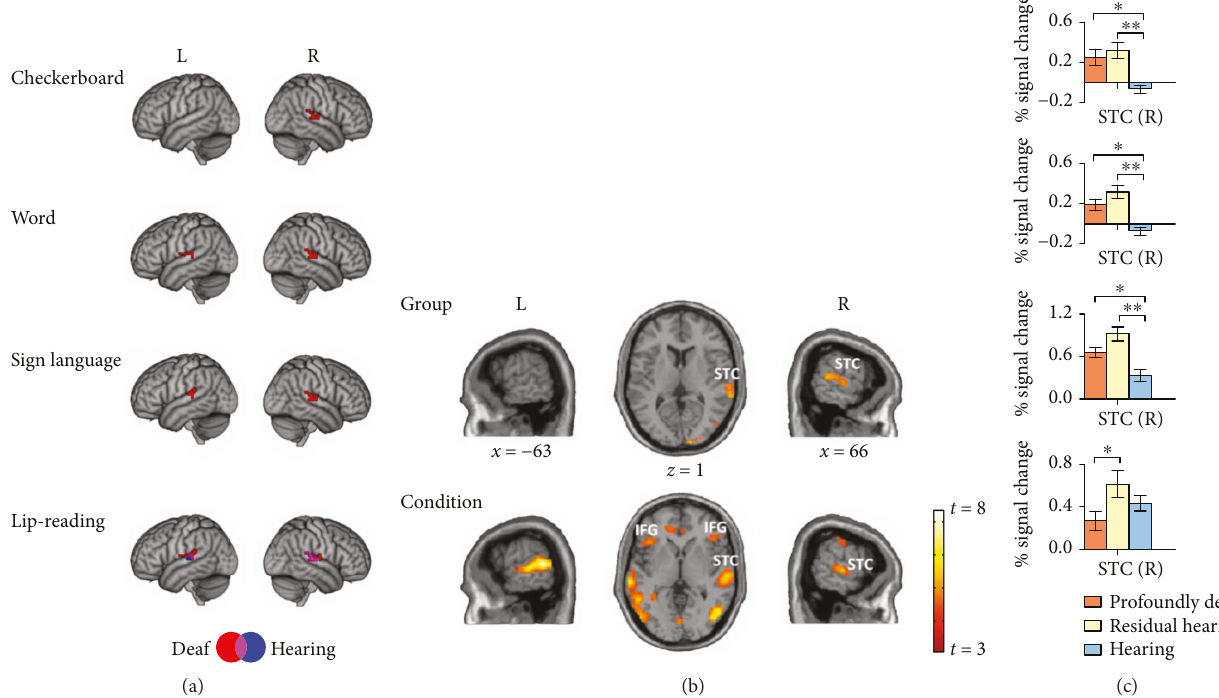
Figure 2: Activations in the superior temporal cortex in response to visual stimuli. (a) Group-level activities for the four visual stimuli are displayed in MNI (Montreal Neurological Institute) standard space. Lateral views of left and right hemispheres showing activity for the checkerboard, word, sign language, and lip-reading stimuli in deaf (red, including both the profoundly deaf and the residual hearing groups, n = 34 ) and hearing (blue, n = 15 ) groups within the brain regions of Brodmann areas (BAs) 41 and 42. The deaf group showed a response to the checkerboard in the right STC region ( p < 0 001 , FDR p < 0 05 corrected). Bilateral STC activations were found under the word and sign language conditions in deaf subjects ( p < 0 001 , FDR p < 0 05 corrected). Both the deaf and the hearing groups showed bilateral activations for the lip-reading stimuli ( p < 0 001 , FDR p < 0 05 corrected). The coordinates and voxel sizes are listed in detail in Table 2. (b) Brain activation to the main e ff ect of Group and Condition are projected on lateral and top views of the brain ( t > 3 0 , p < 0 001 , FDR p < 0 05 corrected). (c) Percent signal change in the regions of interest (10 mm sphere surrounding the peak voxel at 66 − 27 13 in the right STC of the brain map showing the Group e ff ect) of the profoundly deaf (orange, n = 19 ), residual hearing (yellow, n = 15 ), and hearing (blue, n = 15 ) groups. ∗ p < 0 05 (Student ’ s t -test), ∗∗ p < 0 01 . Error bars indicate 1 standard error. L: left hemisphere; R: right hemisphere; STC: superior temporal cortex; IFG: inferior frontal